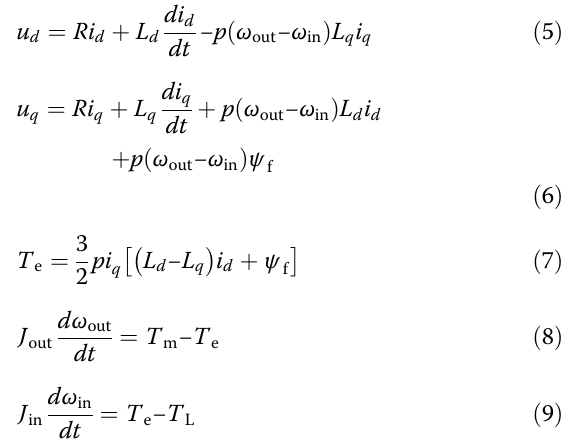
current equation is shown in (5) and (6), the torque equa- tion is shown in (7), and the motion equation is shown in (8) and (9). The dq coordinate system is rotated by the ro- tational speed difference between the inner and outer − ω rotor, that is ω . out in